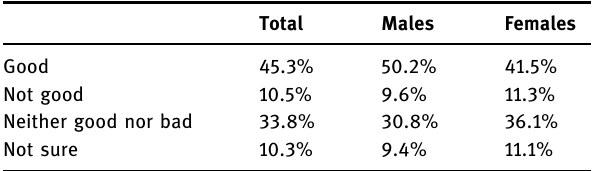
Table 1: “ Love and marriage for elderly ” ( Cabinet O ffi ce, the Government of Japan 1996 Opinion Poll on the Health of Elderly